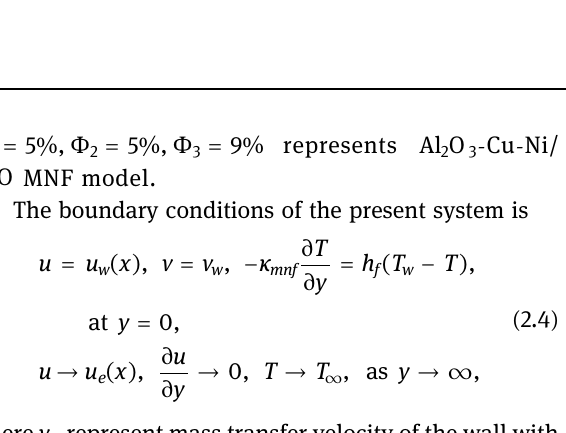
Table 3: Transport characteristics for nanomaterials and water [ 29,30,53